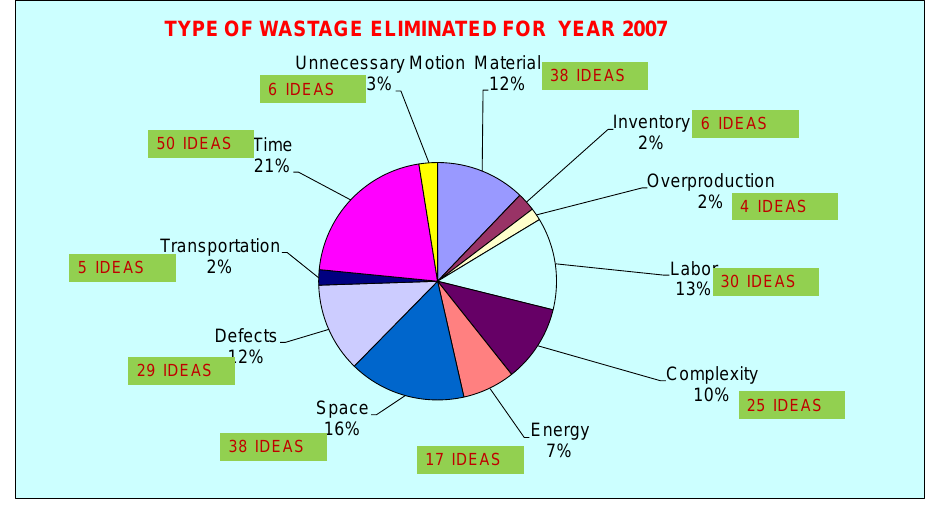
Figure 21. “Type of wastages eliminated for year 2007”.